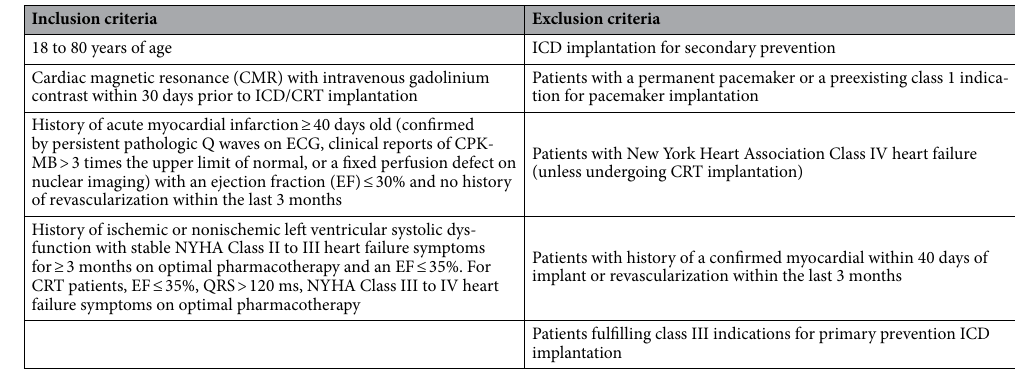
Table 1. CERTAINTY inclusion/exclusion